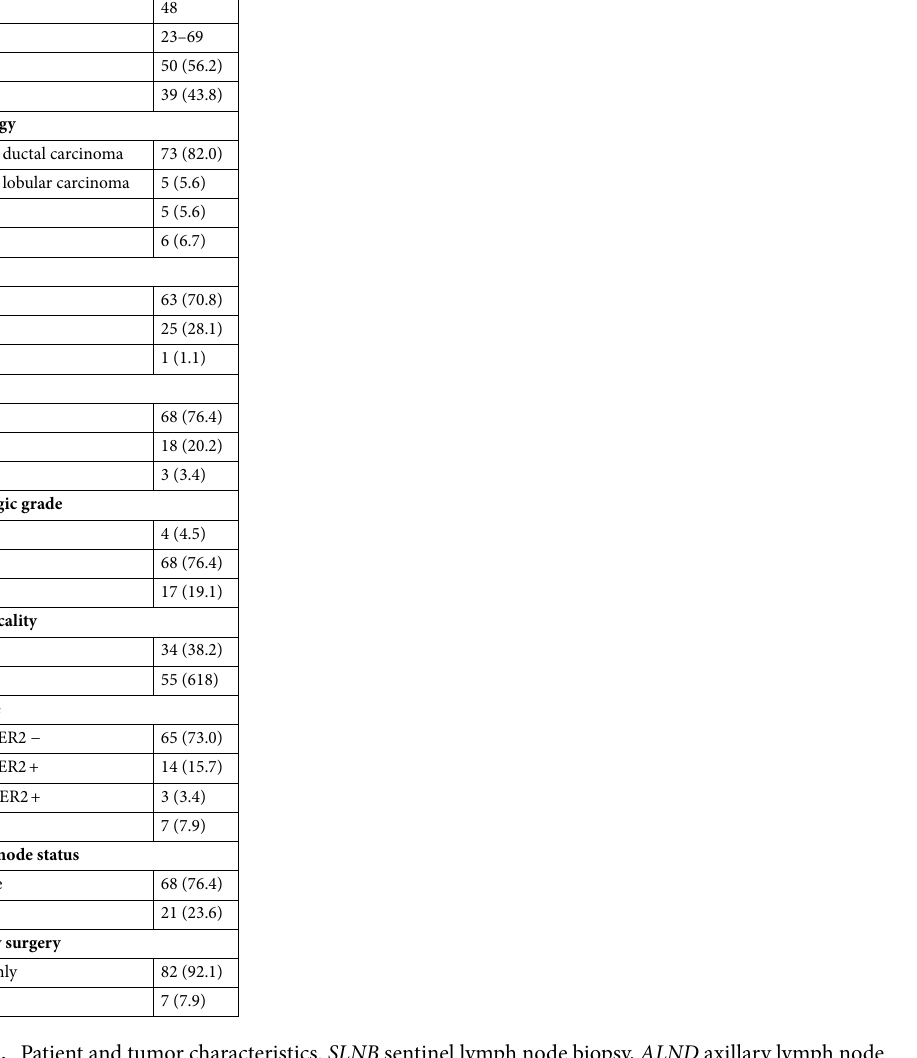
Table 1. Patient and tumor characteristics. SLNB sentinel lymph node biopsy, ALND axillary lymph node dissection, HR hormone receptor, HER2 human epidermal growth factor receptor 2, TN triple